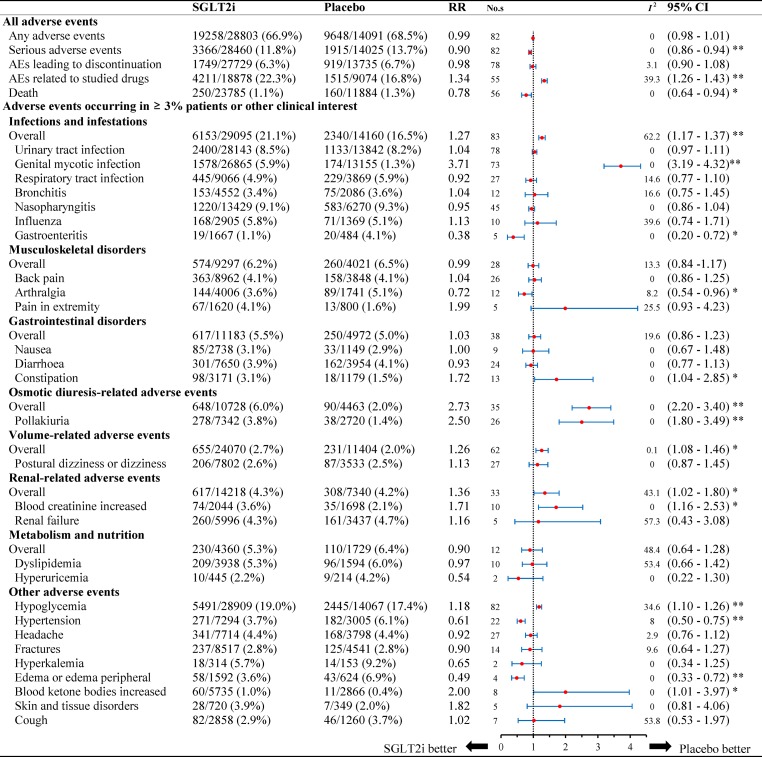
Relative risk of adverse events reported for SGLT2i in comparison to placebo. Abbreviations: No.s, number of studies. * P < 0.05, ** P < 0.001.